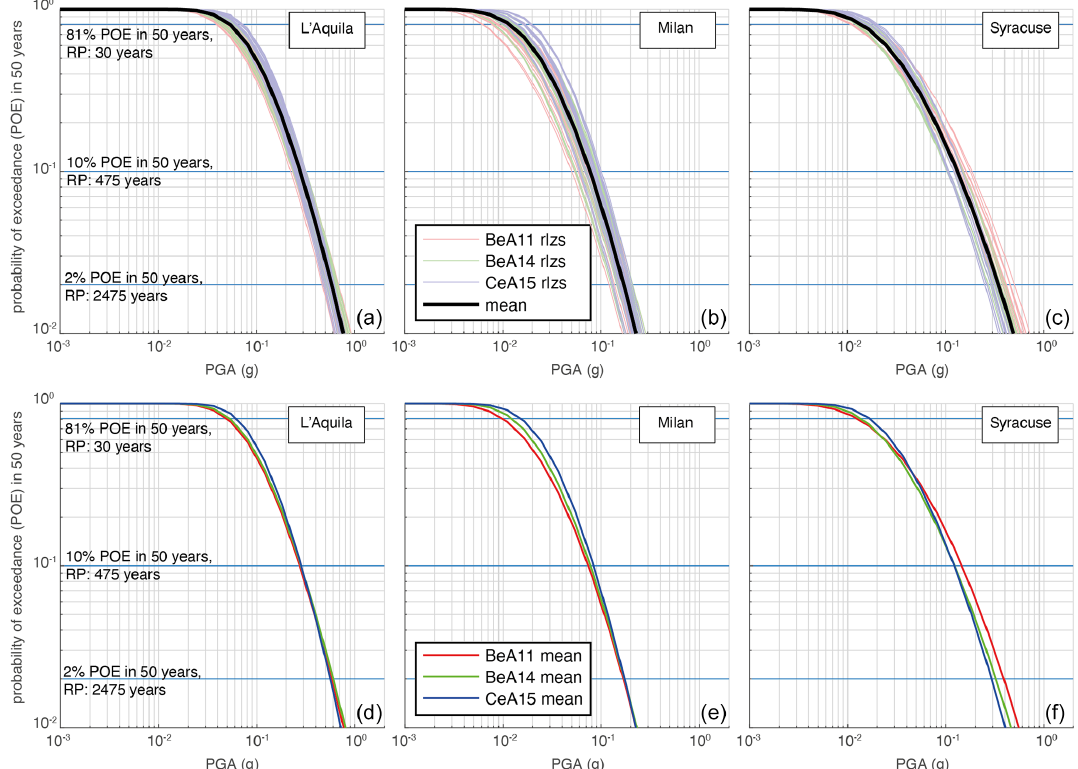
Figure 13. Hazard curves for PGA for the three selected cities. Panels (a) , (b) and (c) show the mean hazard curves (black lines) and the hazard curve of each of the 60 branches (realizations, rlzs, coloured per GMM with pale colours). The legend in panel (b) refers to all panels. Panels (d) , (e) and (f) show the mean hazard curves obtained as a weighted average of the realizations per each GMM (coloured per GMM with bright colours). The legend in panel (e) refers to all panels. Key for all panels is as follows. BeA11: Bindi et al. (2011), BeA14: Bindi et al. (2014), CeA15: Cauzzi et al. (2015).